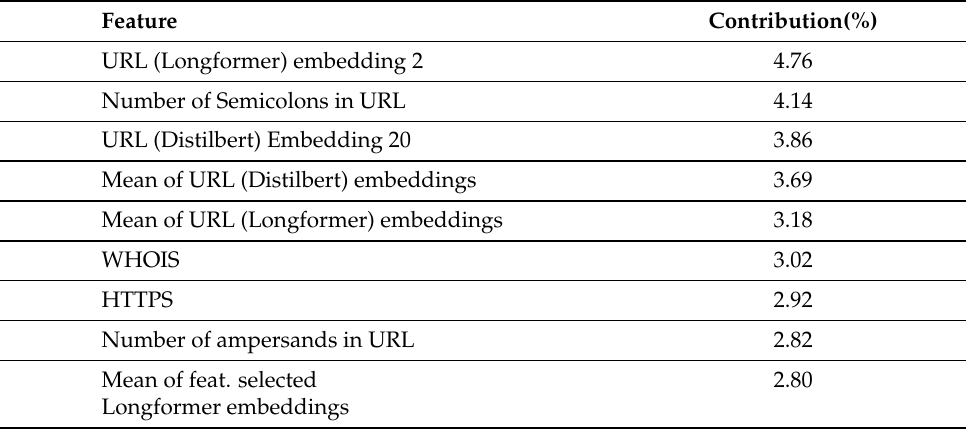
Table 7. Top 10 Contributing Features (with 20 best Chi-squared